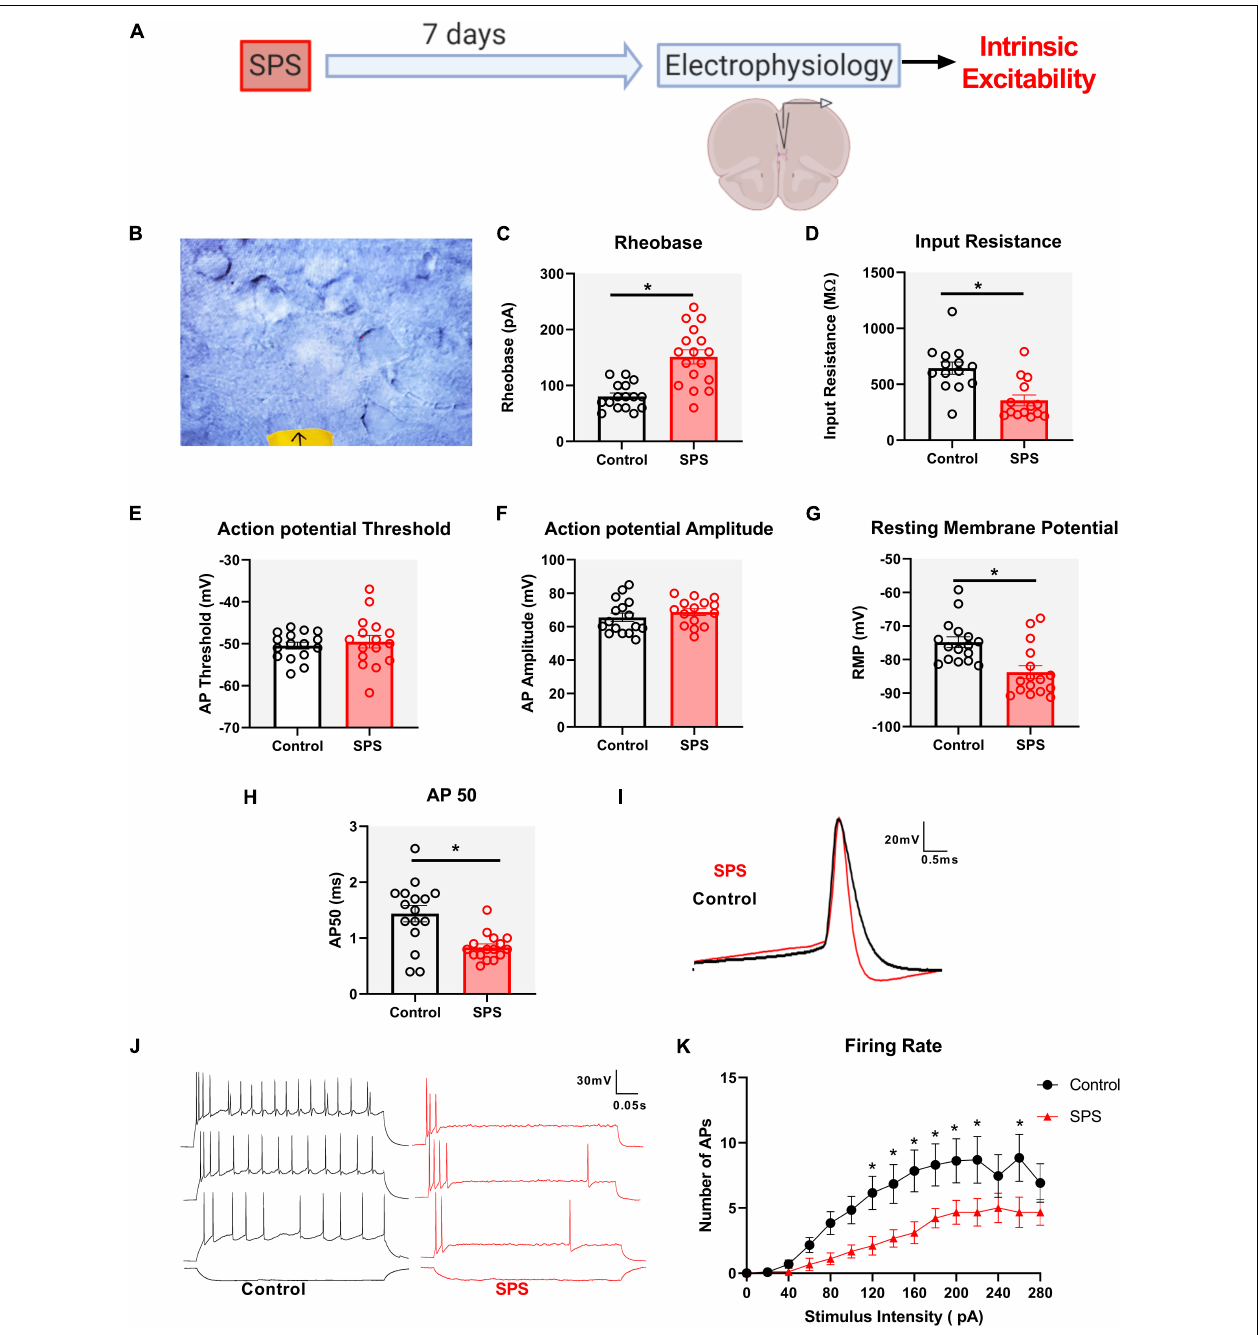
FIGURE 1 | SPS decreases the intrinsic excitability of IL pyramidal neurons. Schematic of the experimental timeline (A) . Image of brain slice obtained using warm slicing protocol is represented in (B) . Healthy pyramidal neurons are triangular in shape and have thick apical dendrite. Electrophysiological recordings in current clamp mode from the IL mPFC were conducted in male rats 7 days post SPS. SPS increases rheobase (C) [ t (31) = 5.6, p < 0.0001], decreases input resistance (D) [Mann–Whitney U (26) = 29, p < 0.01], hyperpolarizes RMP (G) [Mann–Whitney U (34) = 45, p < 0.01], decreases AP 50 (H) [ t (30) = 3.8, p < 0.001] and also decreases firing rate of IL pyramidal neurons (K) with a main effect of SPS [ F (1,20) = 4.7; p < 0.05], main effect of stimulus intensity [ F (14,280) = 20.3; p < 0.01] and a significant SPS X stimulus intensity interaction [ F (14,280) = 2.03; p < 0.01]. The SPS group had a significantly lower action potential firing rate compared to controls at a stimulus intensity range of 120–220 pA and at 260 pA ( p < 0.05). Representative traces of AP50 are shown in (I) . Scale bar: 20 mV, 0.5 ms. Representative traces of action potentials in control (black) vs. SPS (red) groups following –40, 100, 160, and 220 pA current injection are shown in (J) . Scale